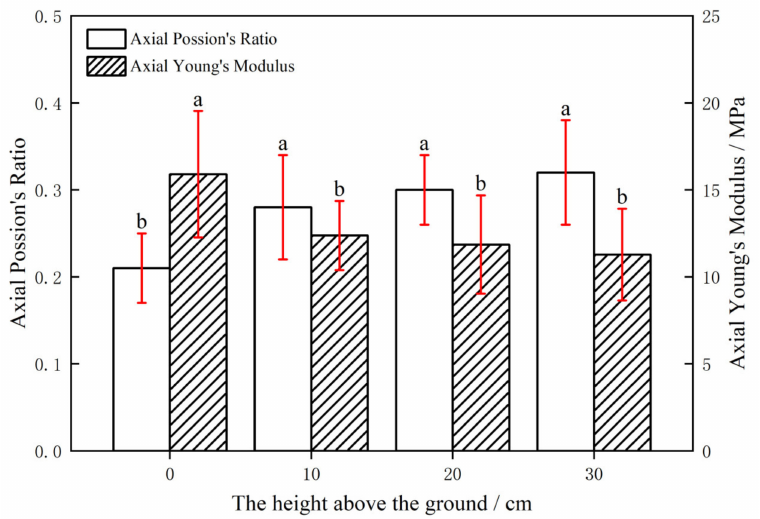
Figure 9. The measurement results of potato main stems. The letters a and b are the results of the Turkey multiple comparison test.